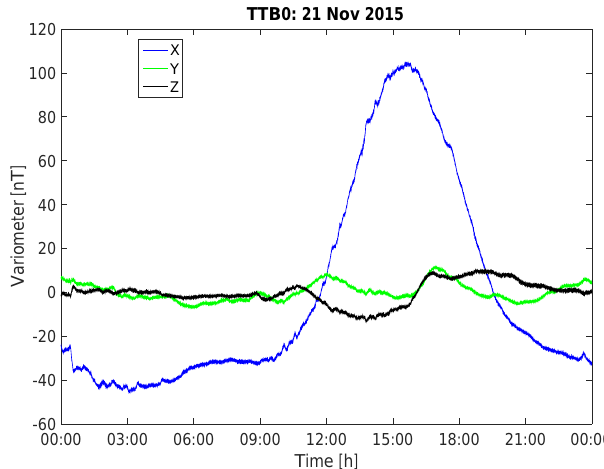
Figure 9. First full day of variometer data of the DTU FGE var- iometer raw data with 1Hz resolution. Time is in UTC. The X - sensor is roughly oriented to magnetic north, and the increased am- plitude during daytime due to the equatorial electrojet is visible.